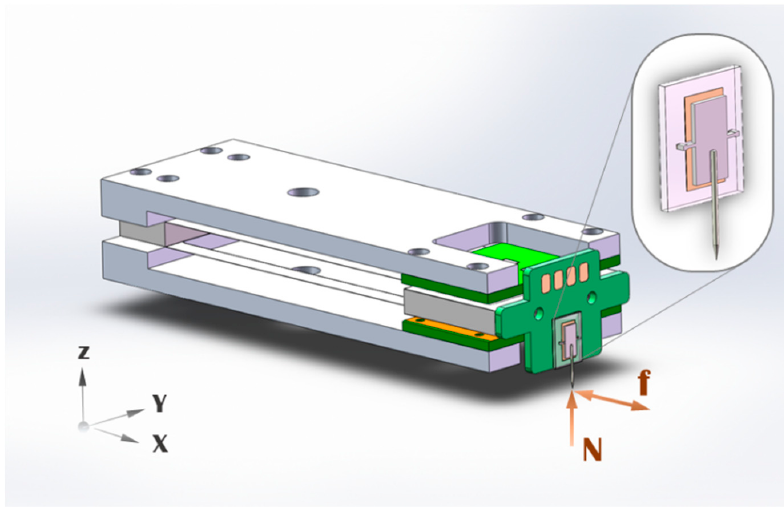
Figure 2. Schematic model of the hybrid two-axis force sensor.